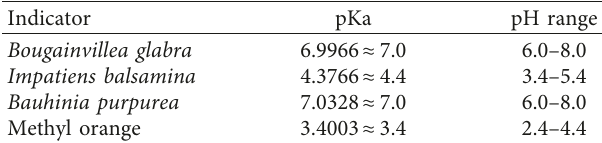
Figure 1: Graph of pH vs. log Bougainvillea glabra , and (d) methyl Table 4: Calculated pKa and pH range of indicators. Indicator pKa pH range